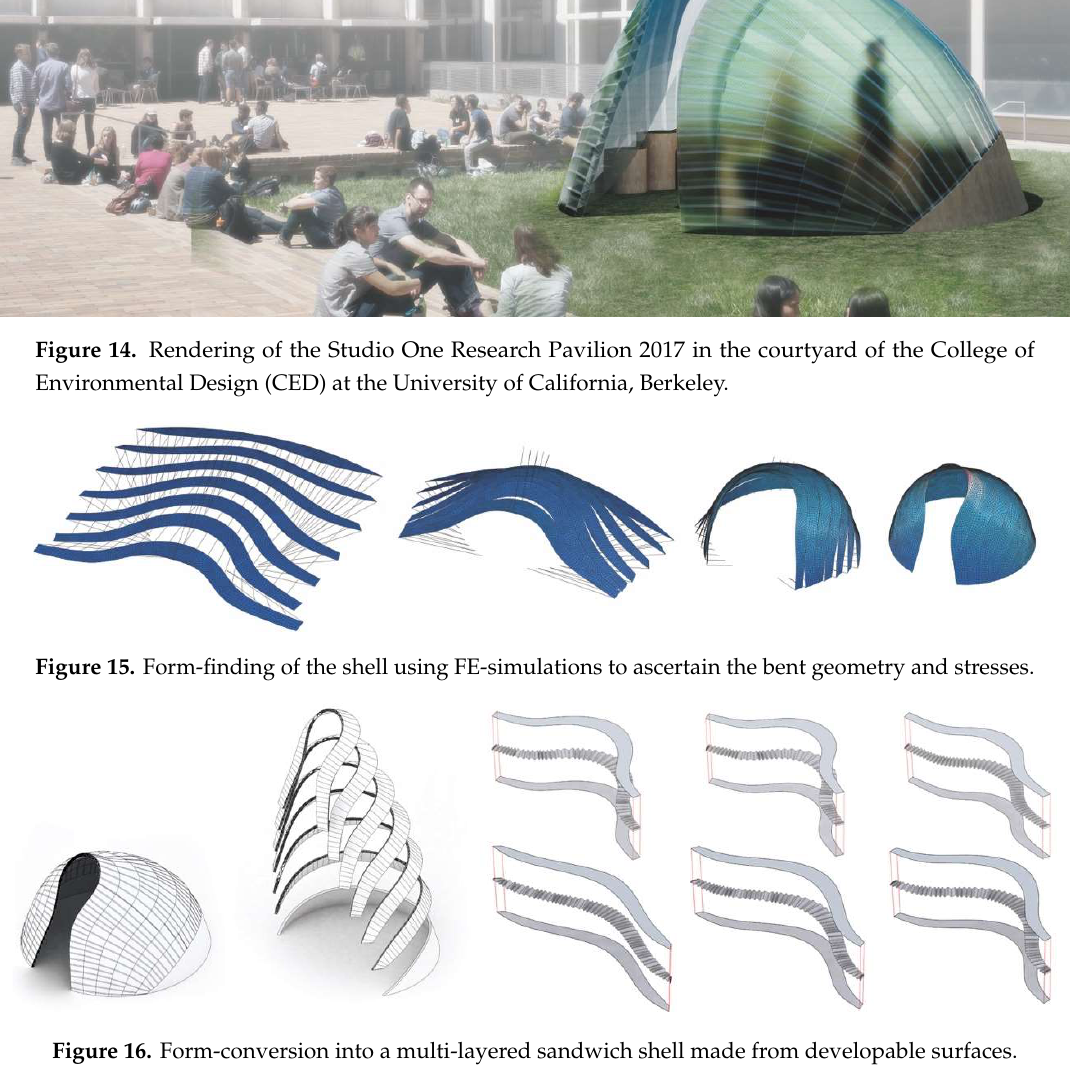
Figure 16. Form-conversion into a multi-layered sandwich shell made from developable surfaces.